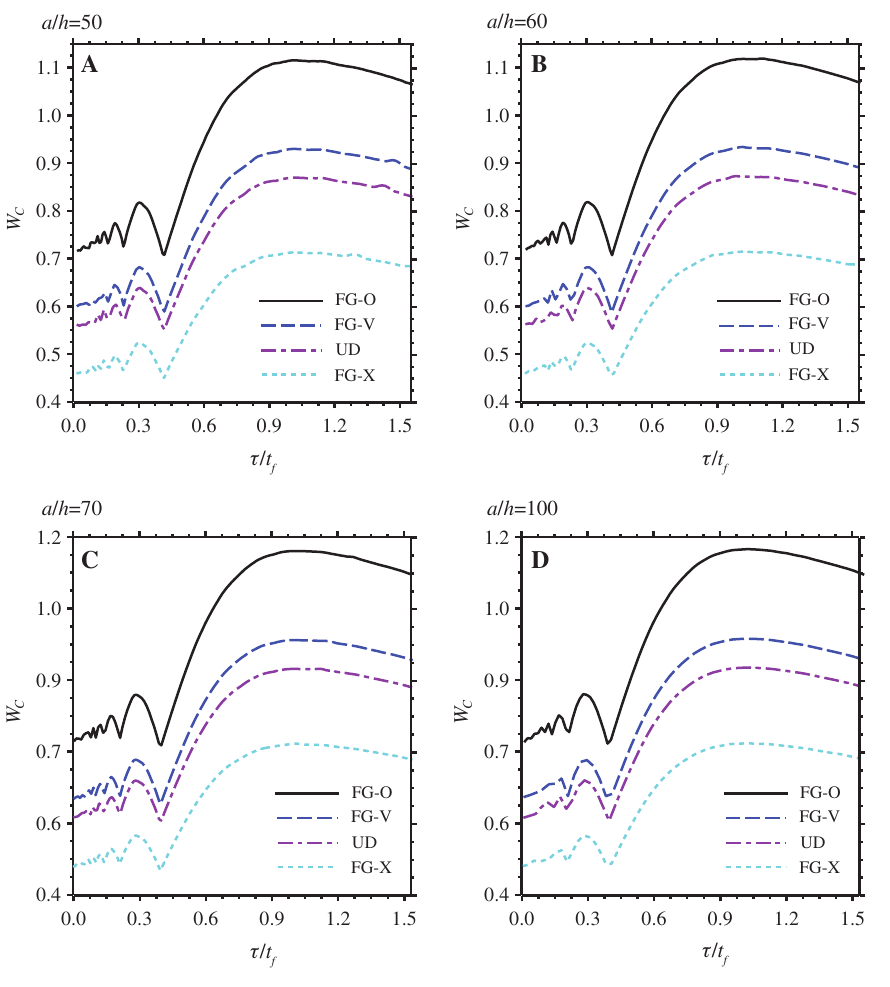
Figure 10 (A–D) Comparison of the maximum normalized dynamic center deflection among plate width-to-thickness ratio for four CNT distributions in simply supported FG